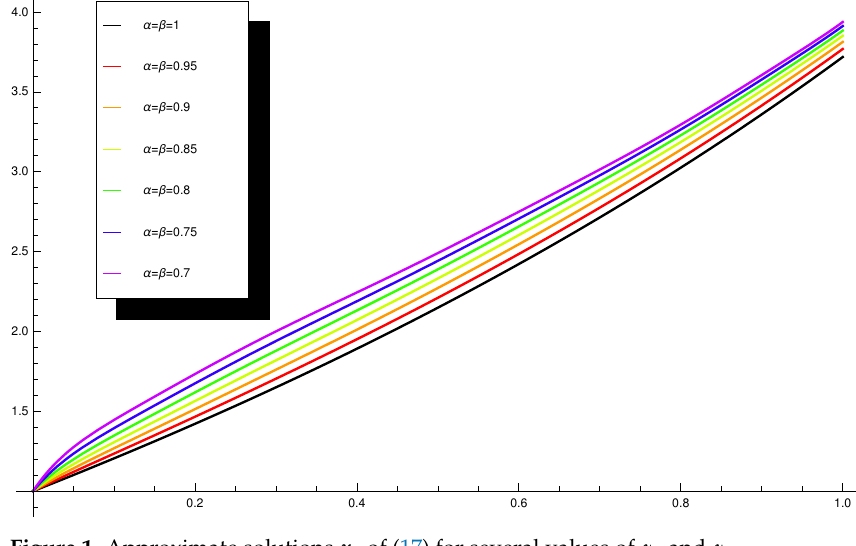
Figure 1. Approximate solutions x 1 of (17) for several values of α 1 and α 2 .